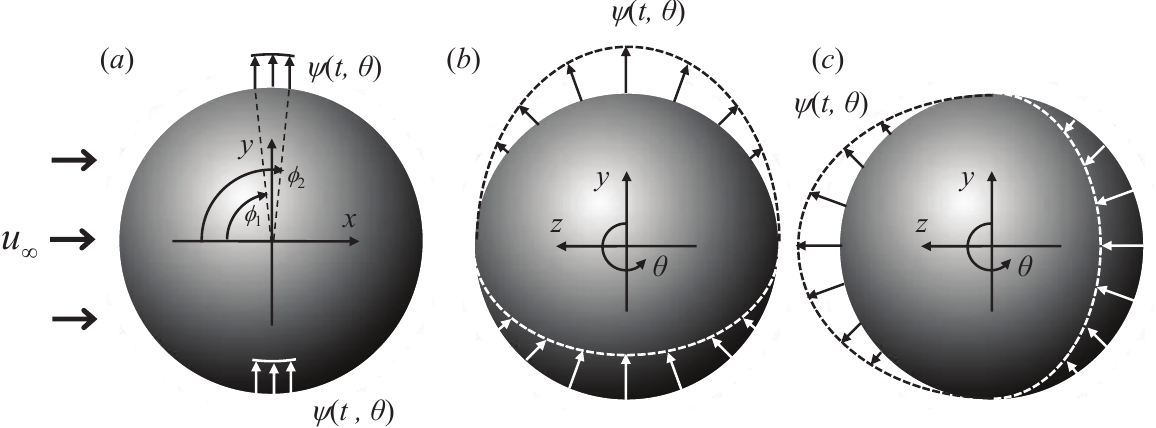
Figure 1. Schematic diagram for periodically rotating distributed forcing on the sphere surface: ( a ) forcing profile in x - y plane; ( b ) forcing profile in y - z plane at t = 0; ( c ) forcing profile in y - z plane at t = 0.25/ f . Here, arrows on the sphere surface indicate blowing/suction forcings. The forcing profile refers to Equation